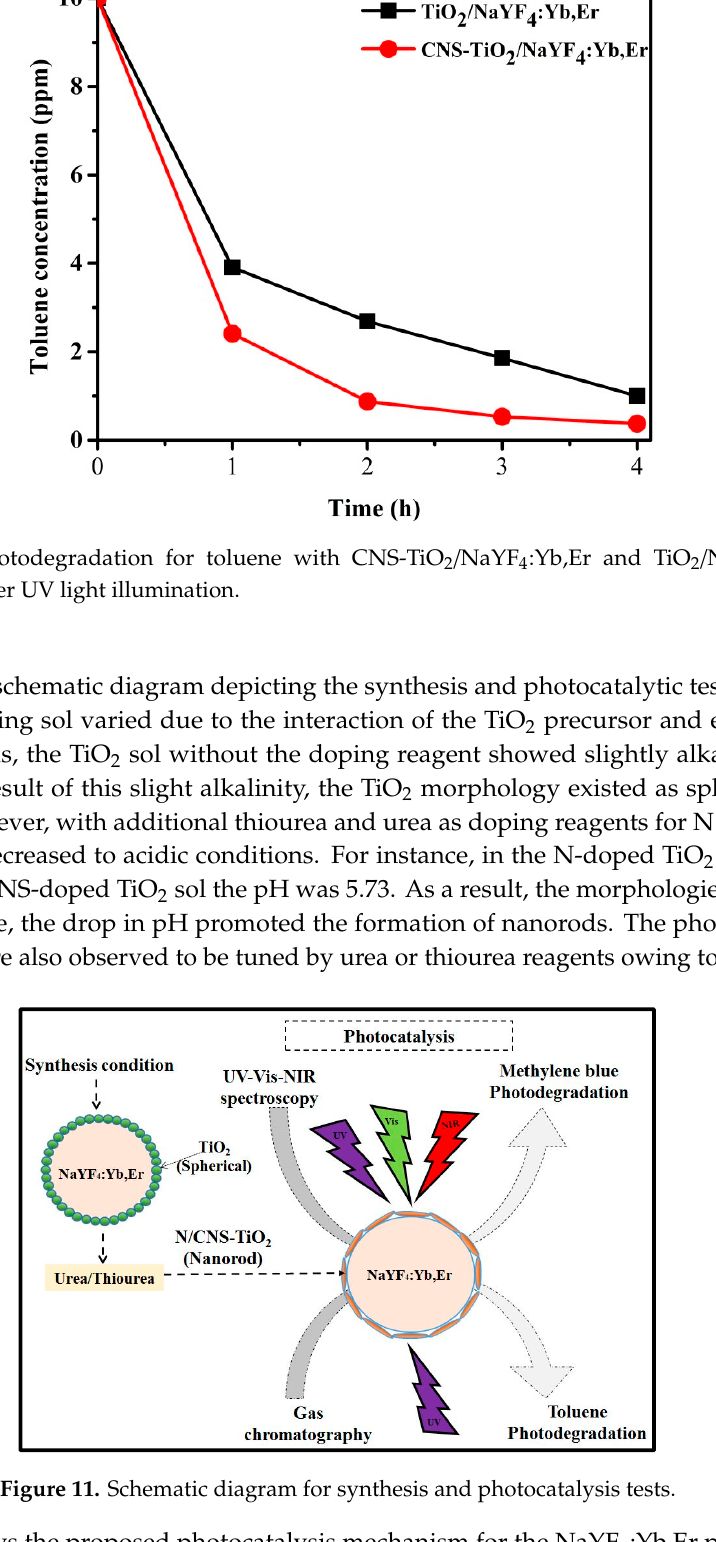
Figure 9. ( a ) MB peak absorbance against the NIR light activation time and ( b ) correlated rate of kinetics.